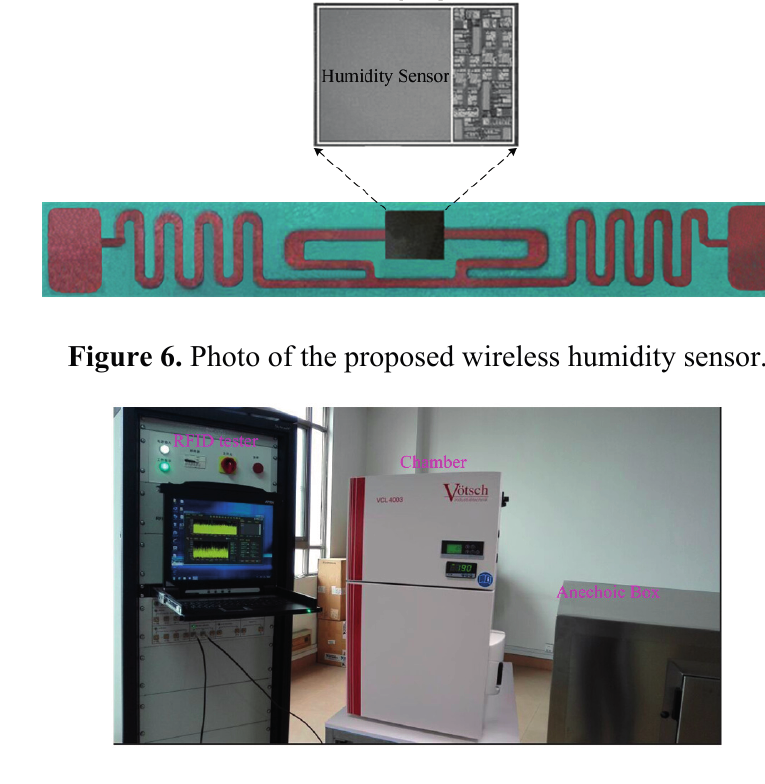
Figure 7. Measurement environment.